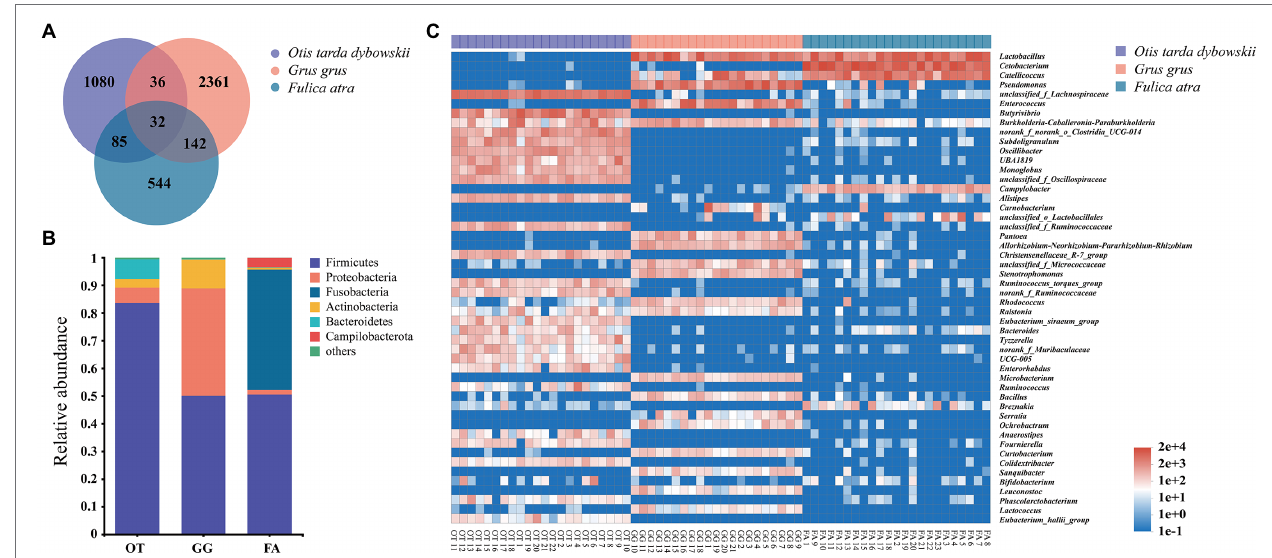
FIGURE 2 | (A) The Venn diagram of the amplicon sequence variants (ASVs) in all the fecal samples. (B) Relative abundance of the microbial communities at the phylum level. The sequences that account for <1% were combined as “others.” OT, Otis tarda dybowskii ; GG, Grus grus ; and FA, Fulica atra . (C) Heatmap showing the microbiota compositions of the top 50 genera in total abundance across all the